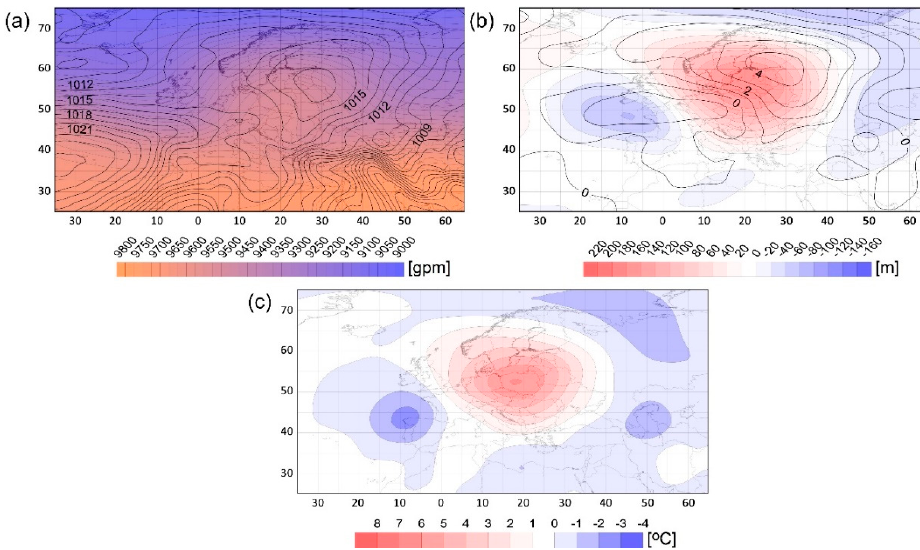
Figure 7. Mean SLP (black lines) and z300 hPa (colour shades) ( a ); anomalies of SLP (black lines) and z300 hPa (colour shades) ( b ); and anomalies of T850 (colour shades) ( c ) during the analysed waves of hot nights.